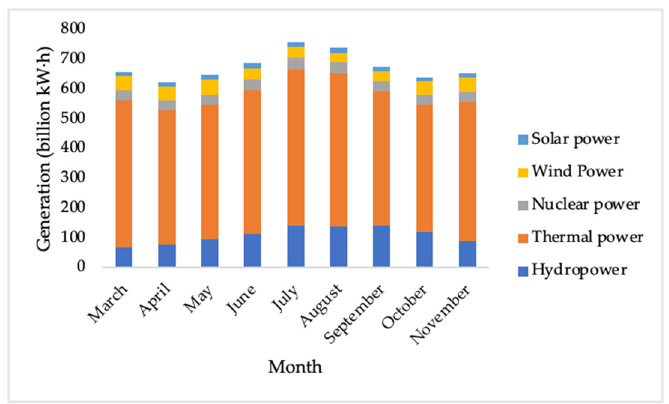
Figure 1. Generation of various energy sources.